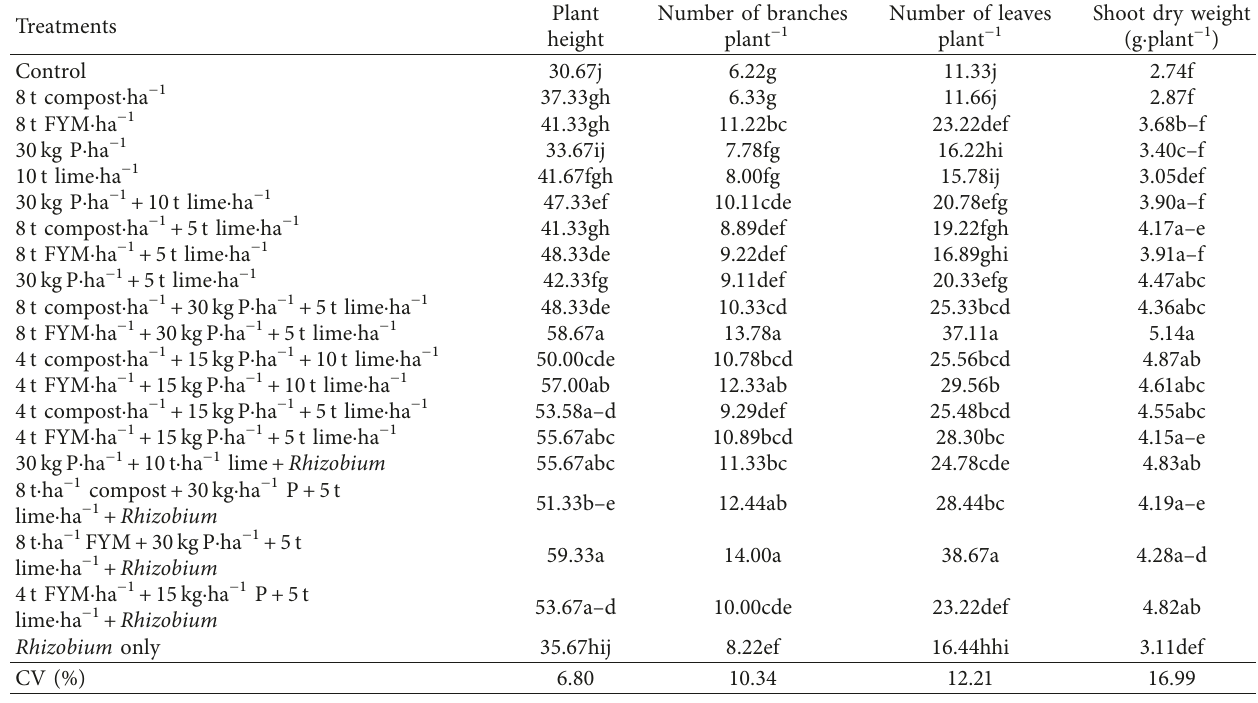
Table 1: Effects of organic and inorganic amendments on the growth of faba bean.